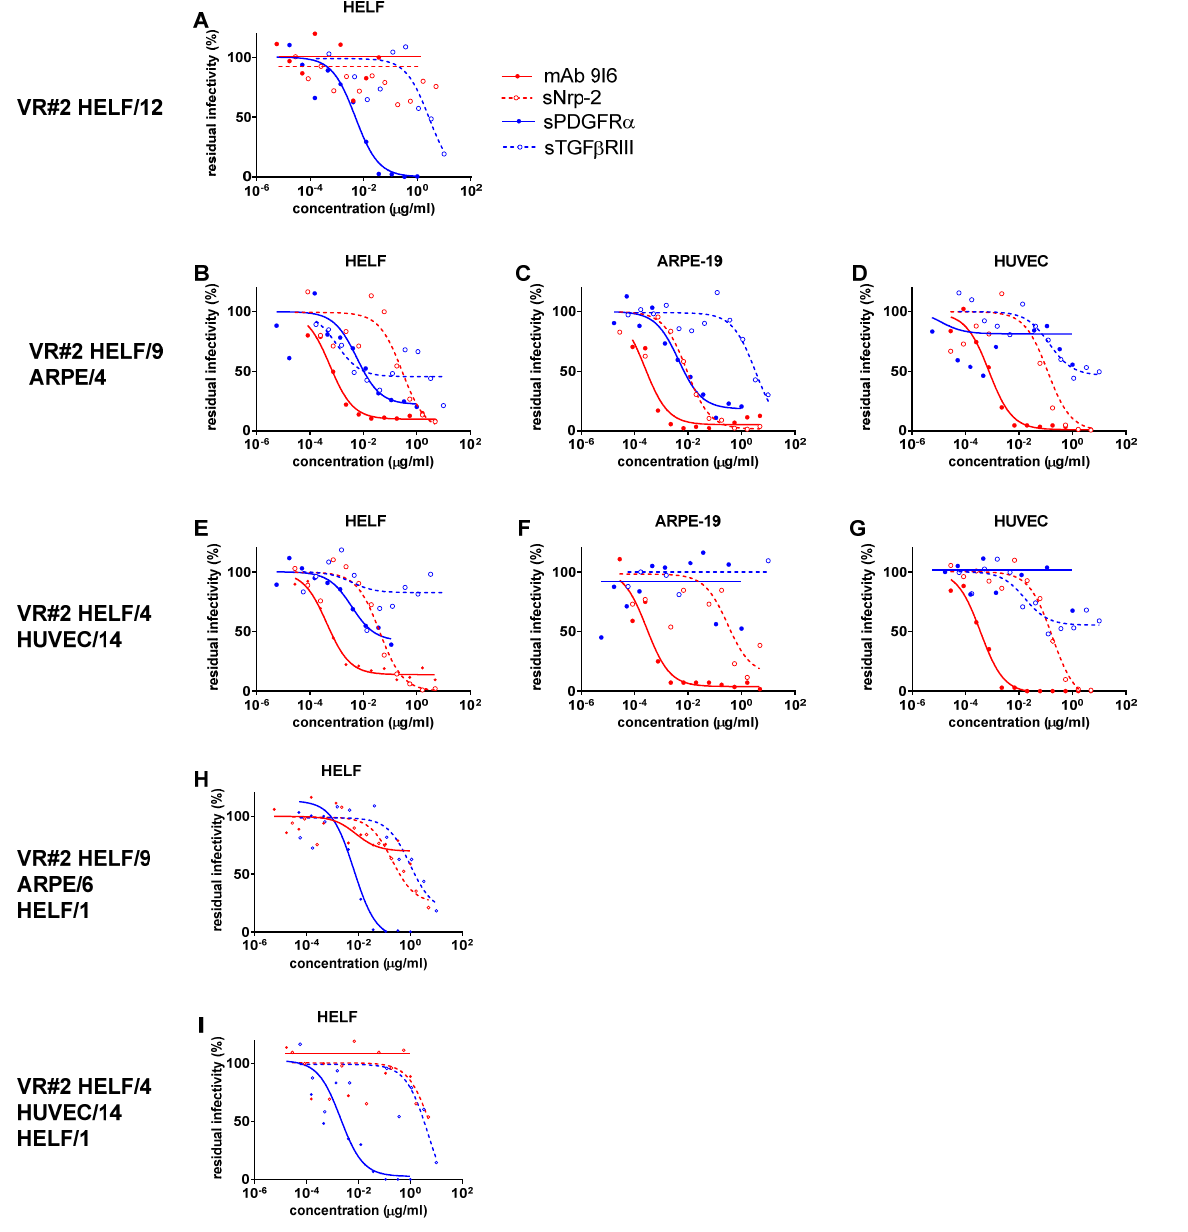
Figure 2. ICs 50 of anti-PC (mAb 9I6, and sNrp-2) and anti-TC (sPDGFR- α , and sTGF β RIII) activity inhibiting infectivity of VR#2, which was recovered and propagated in HELF/12 ( A ), then passaged in ARPE-19/4 ( B – D ) cells, and finally, in HUVEC/14 ( E – G ) primary cells, as determined in HELF ( A , B , E ), ARPE-19 ( C , F ) and HUVEC ( D , G ) cell substrates against residual infectivity. In addition, back passages from ARPE/6 to HELF/1 ( H ) and from HUVEC/14 to HELF/1 ( I ) are